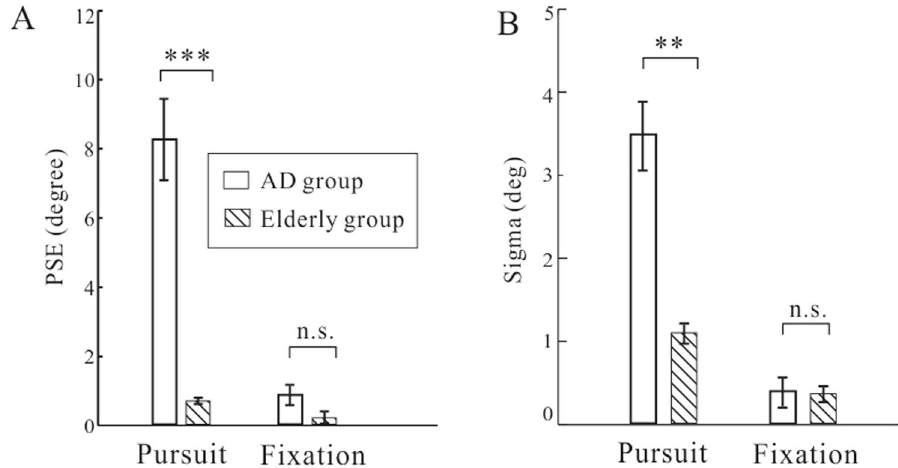
Figure 3. Averaged perceptual bias (indicated by PSE) and perceptual sensitivity (indicated by Sigma) derived from the psychometric function for AD patients ( A ) and healthy participants ( B ) in each condition. Error bars denote mean and